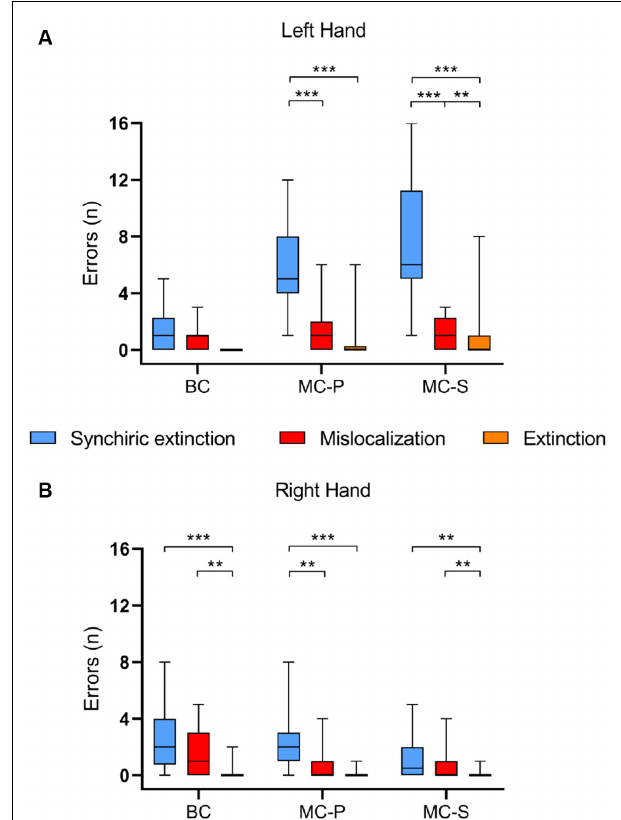
FIGURE 3 | Group performances on the Baseline condition (BC), Mirror Condition-Pointing (MC-P), and Mirror Condition-Silhouette (MC-S). The graph depicts the median value of synchiric extinction, mislocalization errors, and extinction for each condition regarding (A) the left-hand and (B) the right-hand. Boxes represent the first to the third quartile, whiskers represent the data range. ** p < 0.01; *** p < 0.0001.